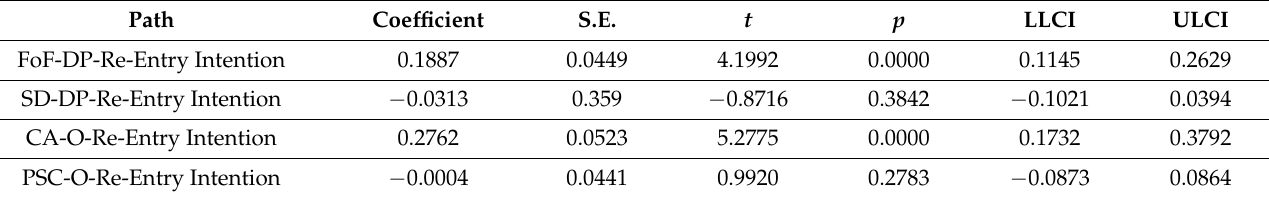
Table 6. Mediation analysis.